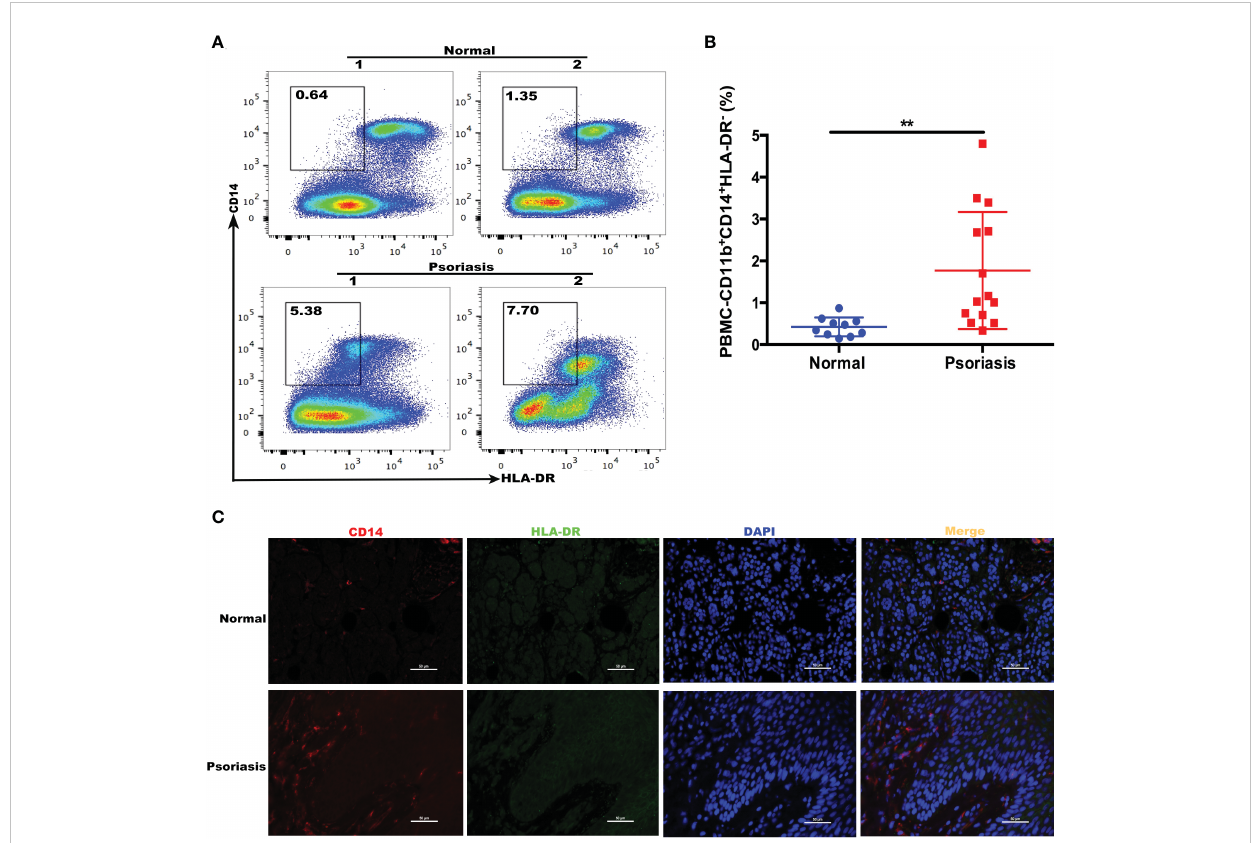
FIGURE 2 Expansion of MDSCs in the blood of patients with psoriasis. (A) HLA-DR and CD14 expression in freshly isolated PBMCs from healthy individuals (controls) and patients with psoriasis (psoriasis). CD11b + CD14 + HLA-DR -/low cells were gated (shown by a small window). (B) Scatter plots of M- MDSCs from PBMCs. (C) Immuno fl uorescence staining of M-MDSCs (CD14 + HLA-DR - ) in skin lesions in patients with psoriasis (N = 7) and controls (N = 5). Red represents anti-CD14; green, anti-HLA-DR; yellow, CD14 and HLA-DR merged; and blue, DAPI. Original magni fi cation, 400×. **P < 0.01. DAPI, 4 ’ ,6-diamidino-2-phenylindole; HLA-DR, human leukocyte antigen DR; MDSC, myeloid-derived suppressor cell; M-MDSC, mononuclear MDSC; PBMC, peripheral blood mononuclear